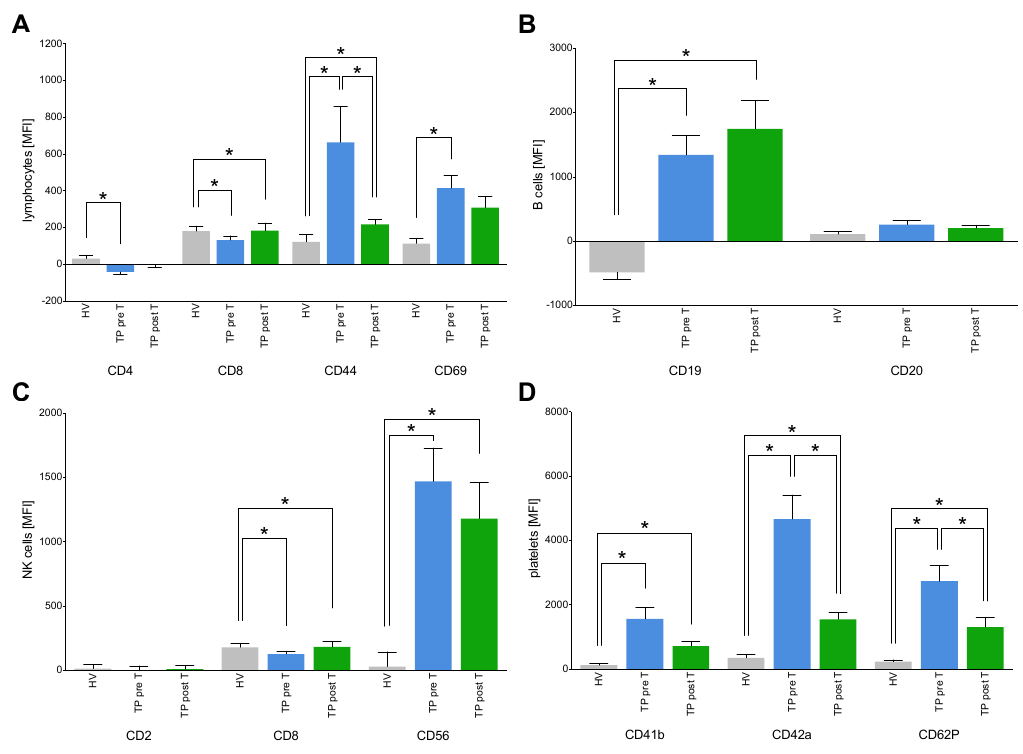
Figure 4. Expression of cluster of differentiation (CD) surface proteins on isolated extracellular vesicles (EVs) specific for lymphocytes ( A ), B cells ( B ), NK cells ( C ) and platelets ( D ). The EVs derived from healthy volunteers (HV) and cholangiocellular carcinoma (CCA) tumor patients (TP) before (pre T) and after (post T) receiving a selective internal radiation therapy. The mean fluorescent intensity (MFI) is given as mean ± standard error of the mean. * p < 0.05 vs. indicated group.